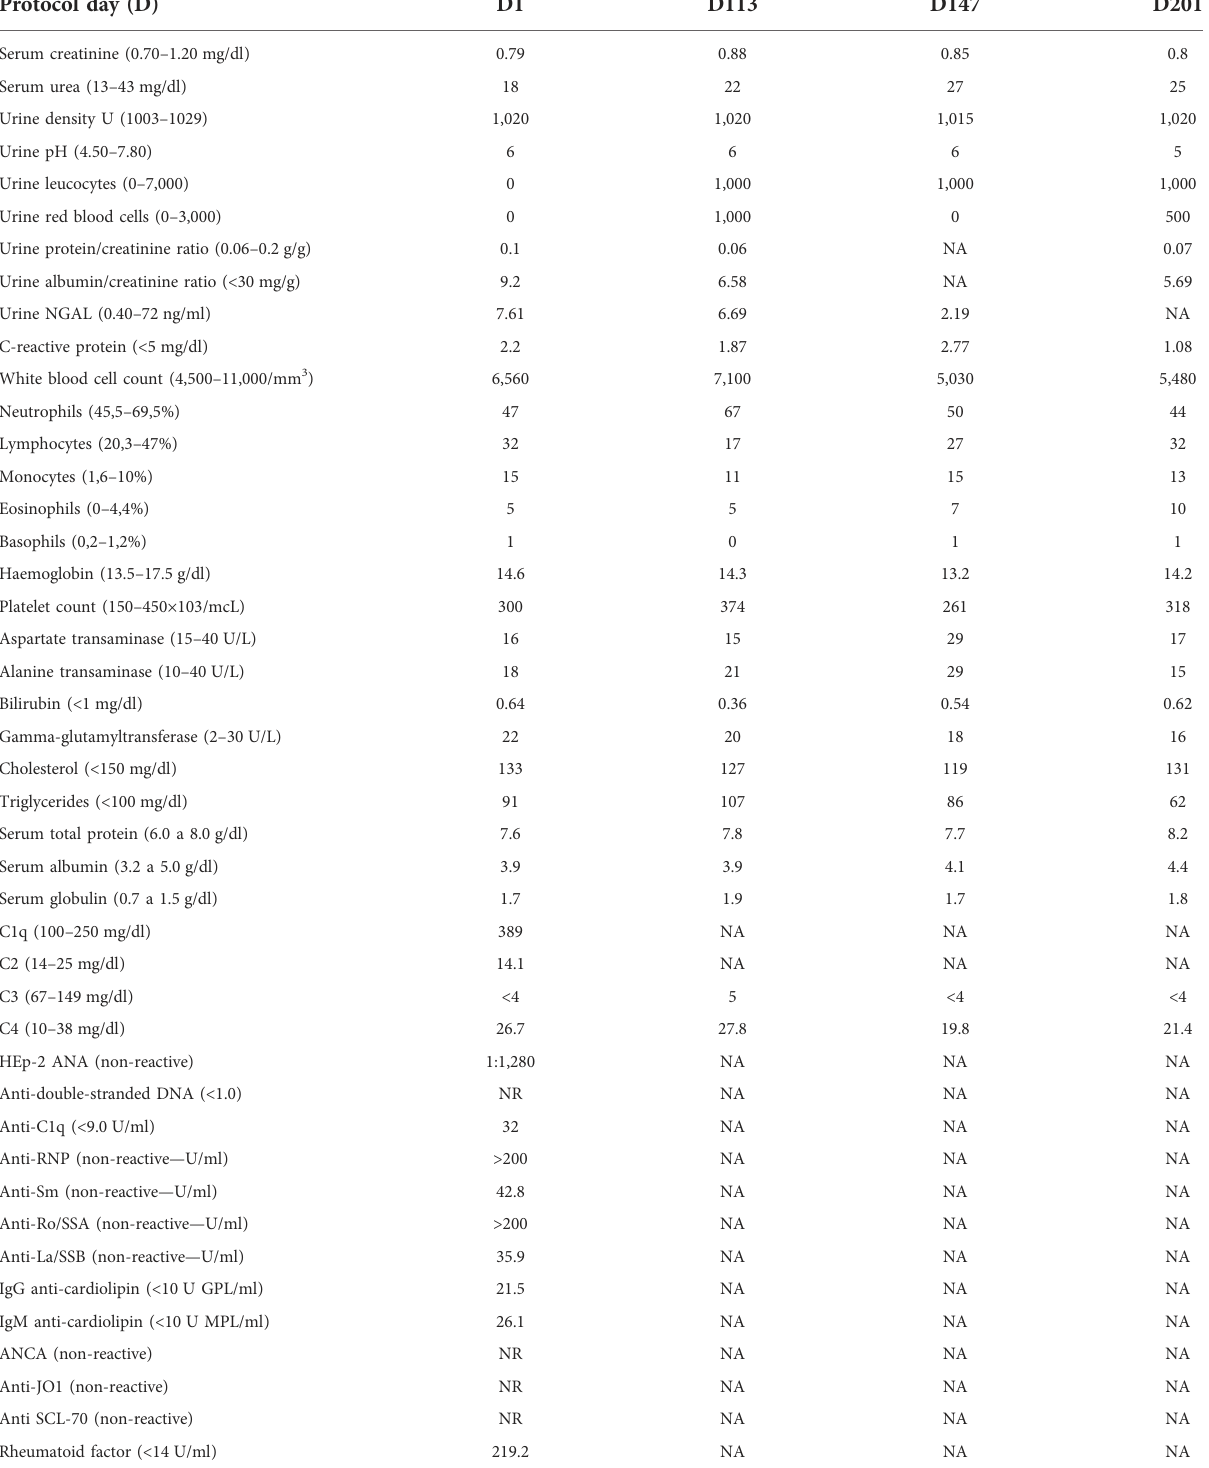
TABLE 2 Laboratorial tests assessed pre-treatment at D0, D113 in regular use of Theracurmin® 4 g every 12 h, D147 after 11 days washout, and D201 in regular use of Hydroxychloroquine 400 mg. Protocol day (D) D1